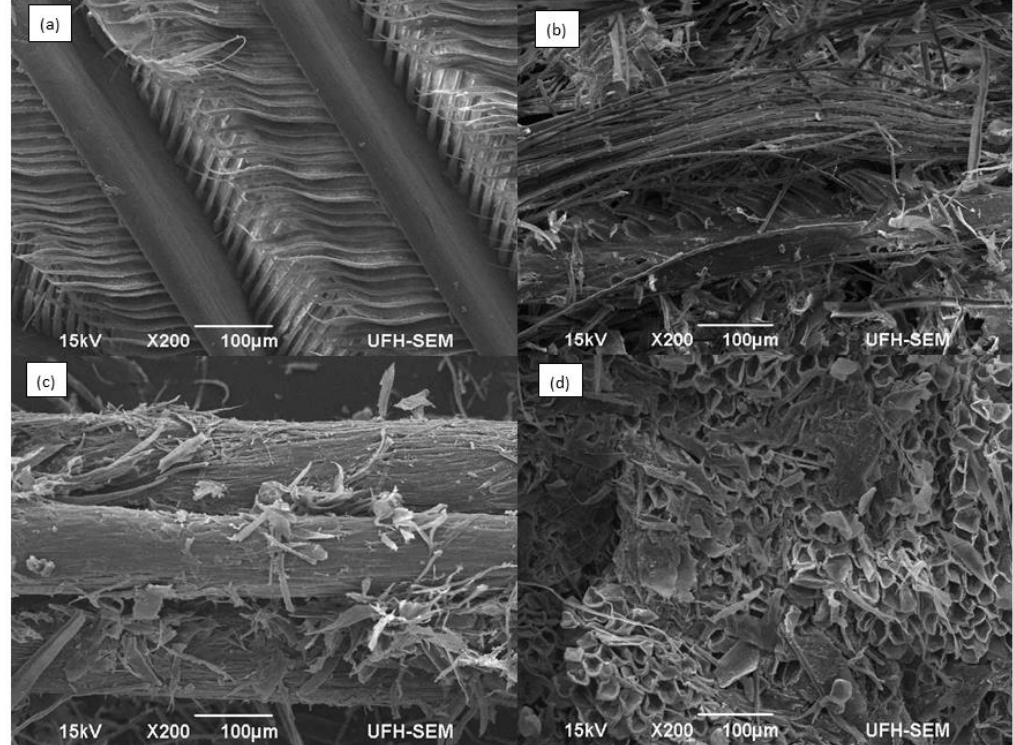
Figure 10. Electron micrography of feather degradation by Bacillus sp. FPF-1: ( a ) control (un-inoculated feather); ( b ) chicken feather at 24 h of fermentation; ( c ) feathers after 48 h fermentation; and ( d ) feathers after 72 h of cultivation.